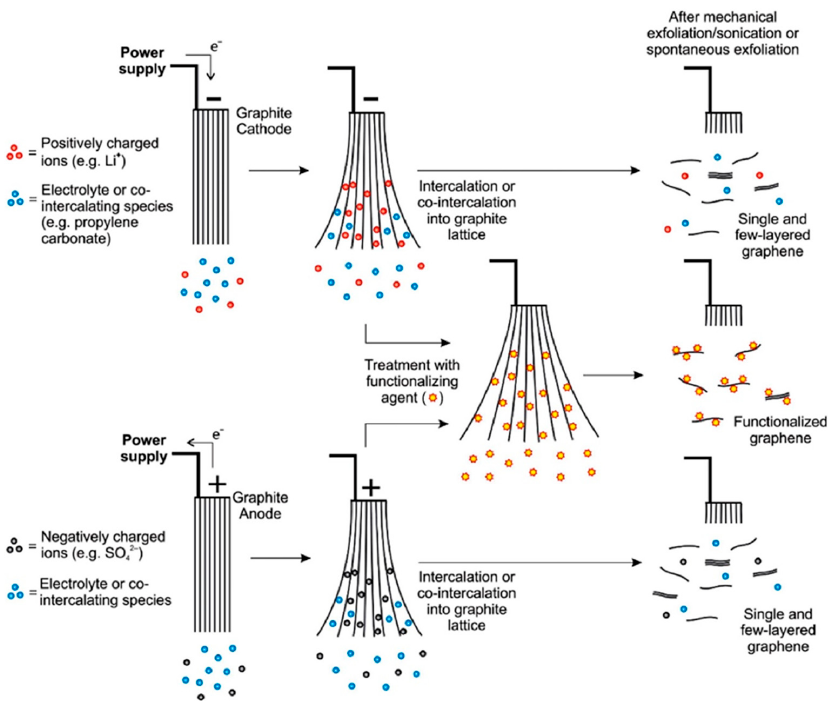
Figure 4. A schematic overview of mechanism of cathodic and anodic exfoliation. Functionalization of graphene may be achieved either during exfoliation by introducing functionalizing agent or after exfoliation. Reprinted with permission from Yu, et al. [83]. Copyright (2015)